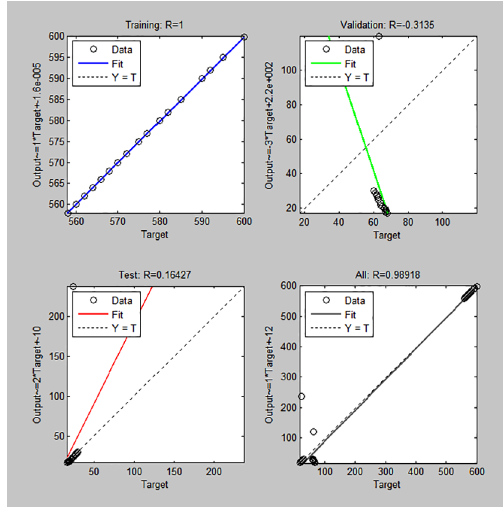
Figure 16. The MSE and TRANSIG activation function’s regression analysis chart